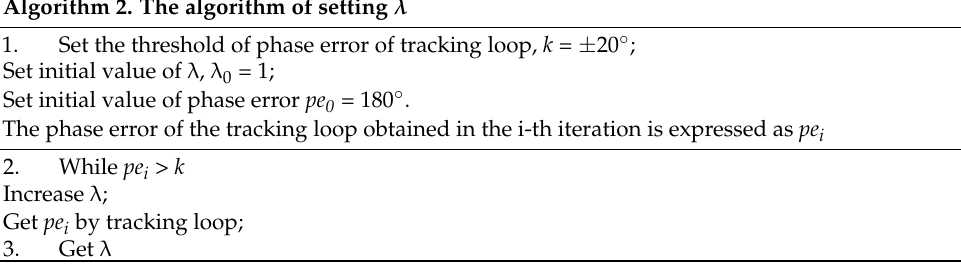
Algorithm 2. The algorithm of setting λ